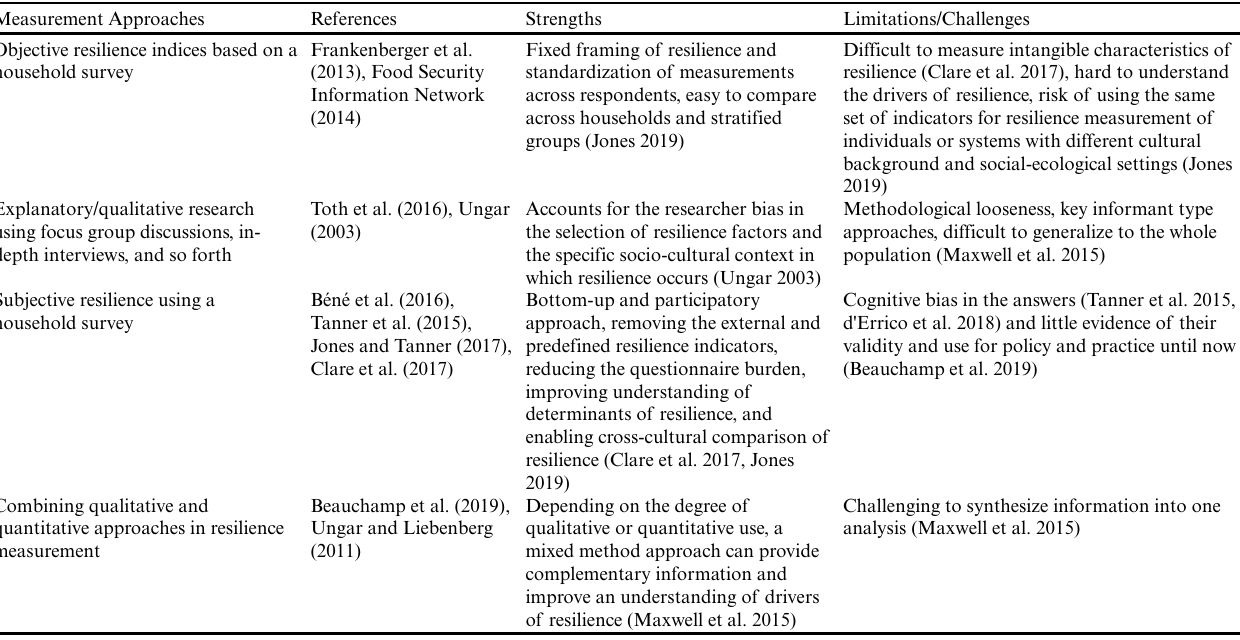
Table 1 . Different approaches in resilience measurement.